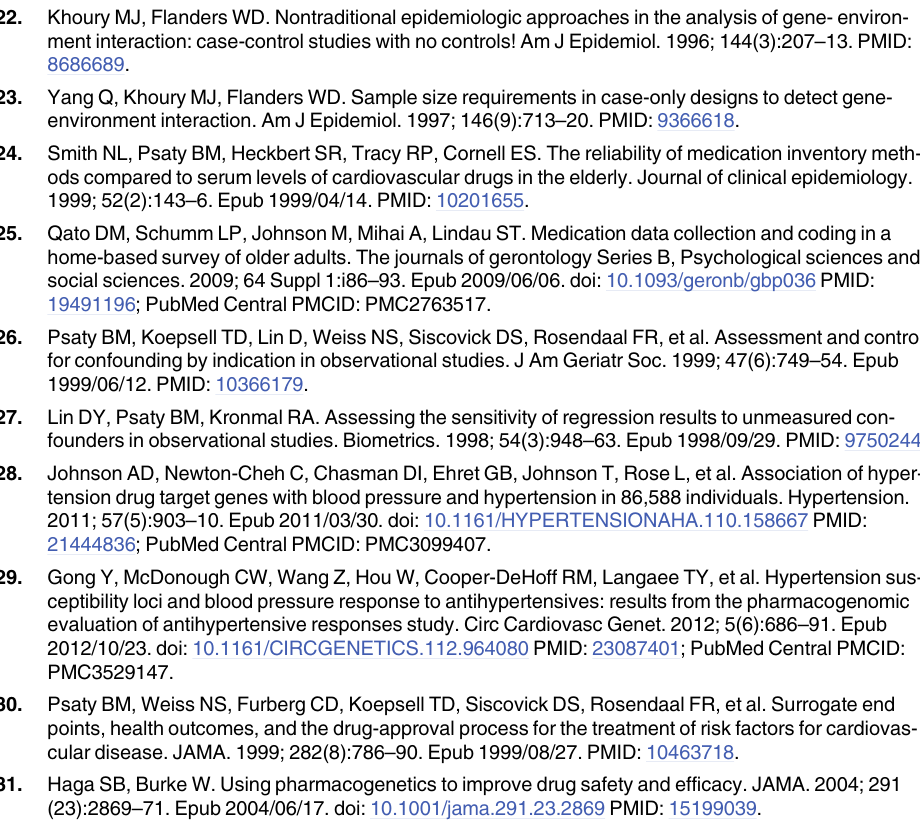
PLOS ONE | DOI:10.1371/journal.pone.0140496 October 30,